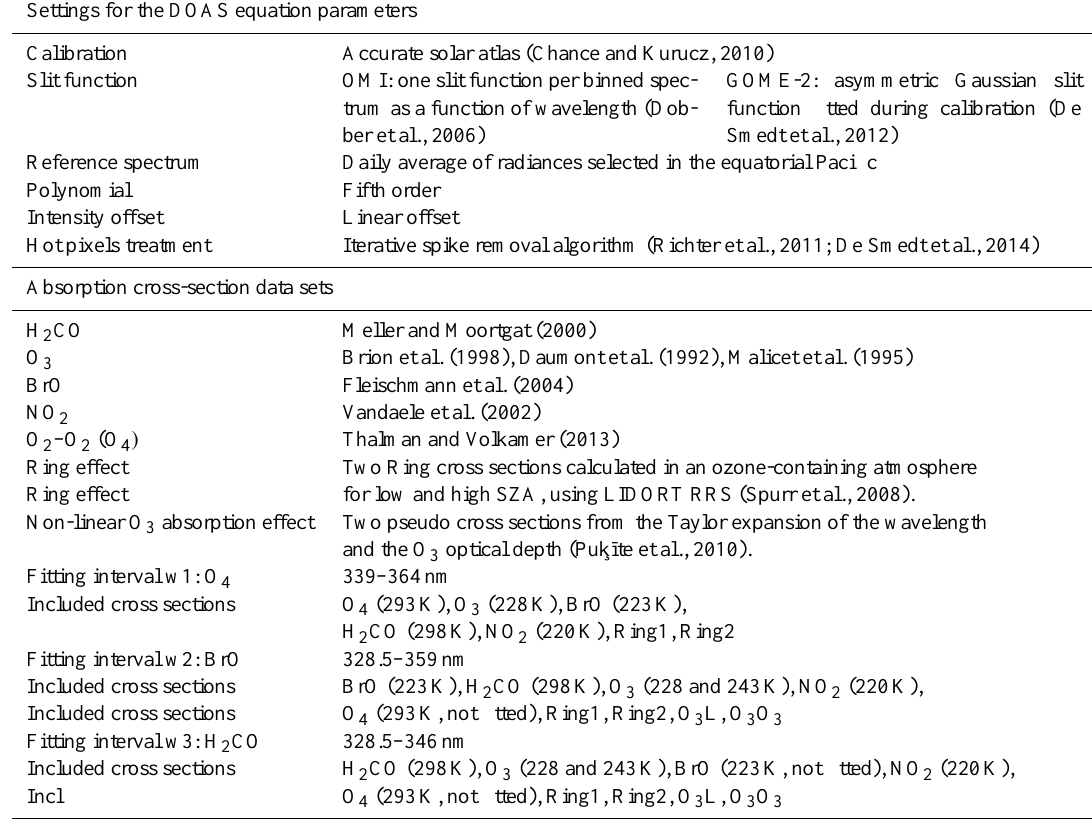
Table 1. Summary of retrieval settings used in version 14 of the BIRA H 2 CO retrieval algorithm, applicable to GOME-2 and OMI measure-